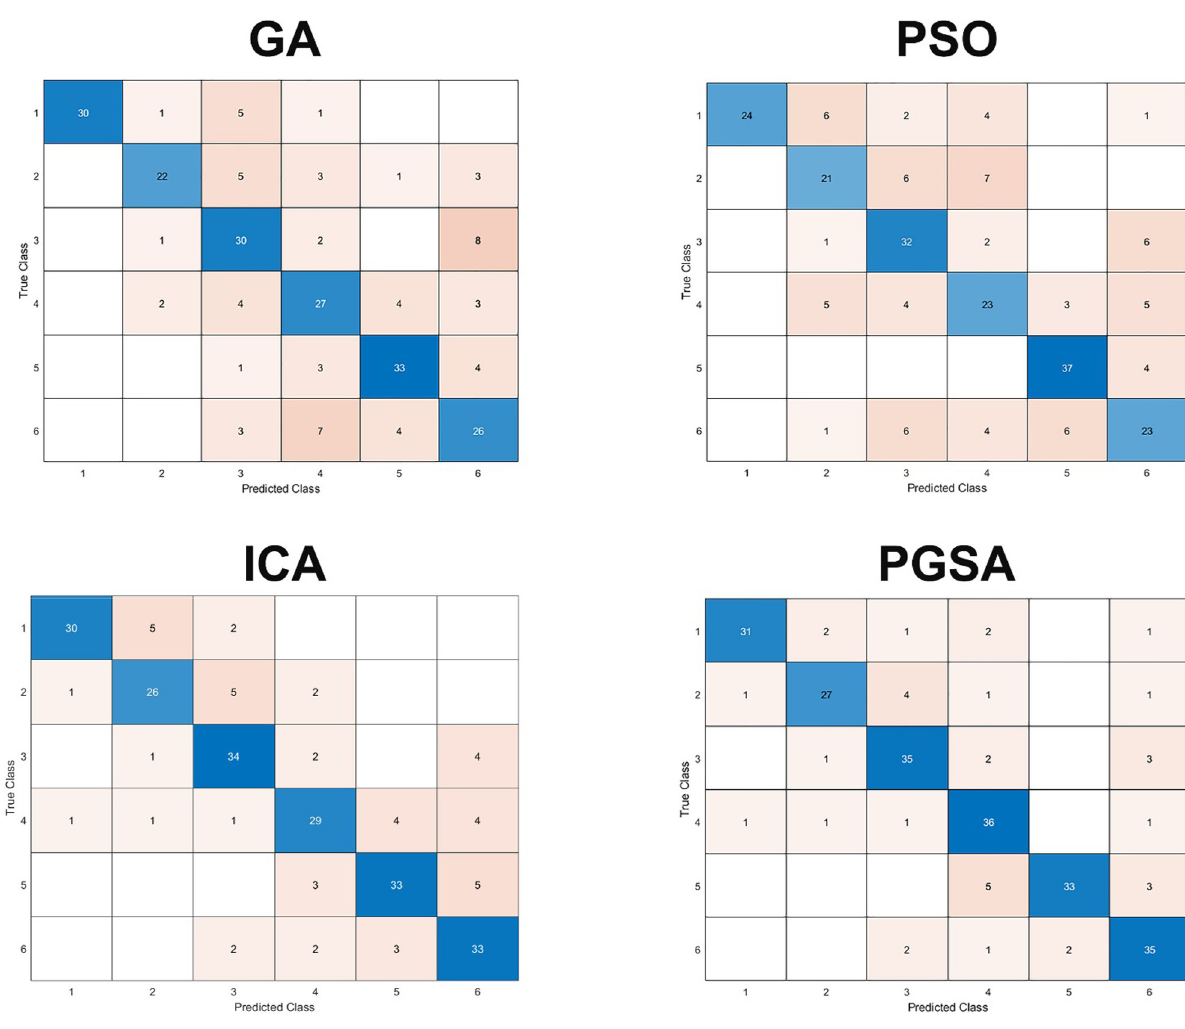
Fig 3. Confusion matrix of optimization